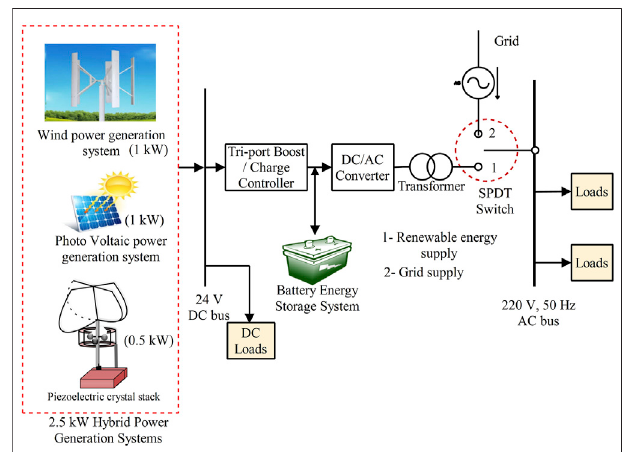
FIGURE 1 | Developed smart microgrid for